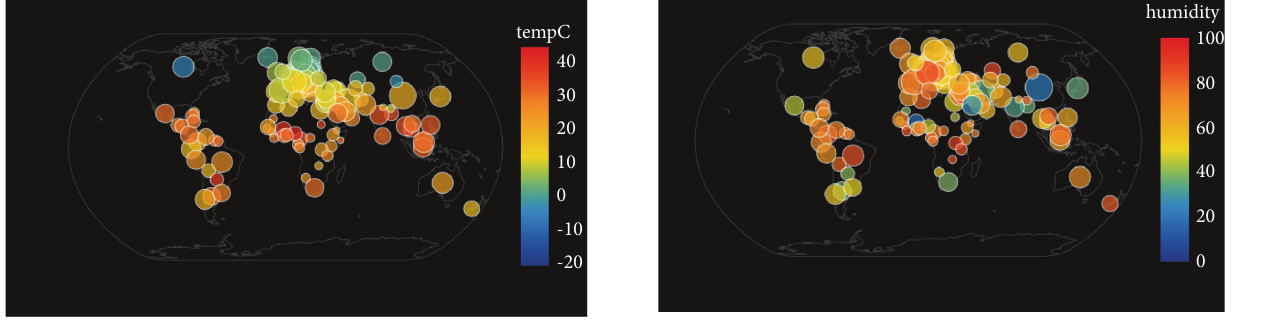
Figure 4: Relationship of temperature with coronavirus spread.